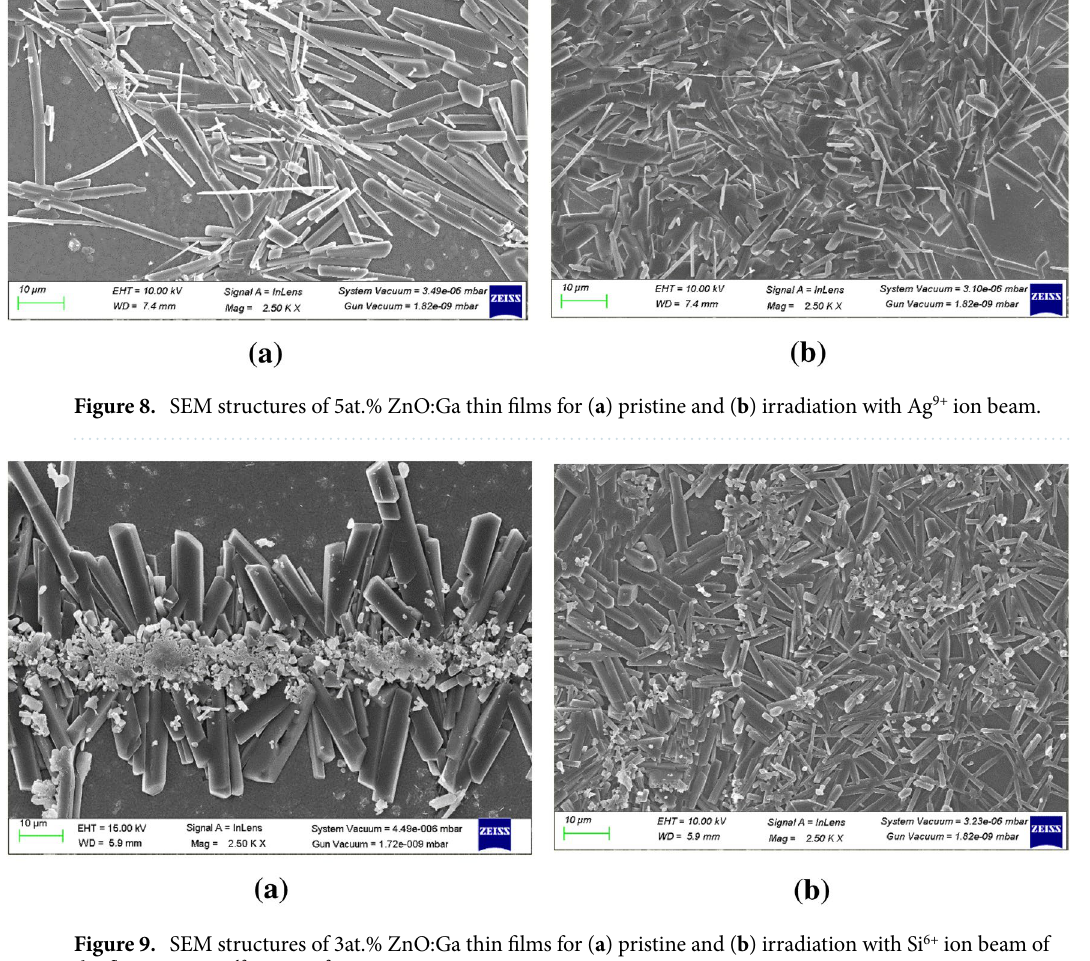
Figure 9. SEM structures of 3at.% ZnO:Ga thin films for ( a ) pristine and ( b ) irradiation with Si 6+ ion beam of the fluences 5 × 10 13 ions/cm 2